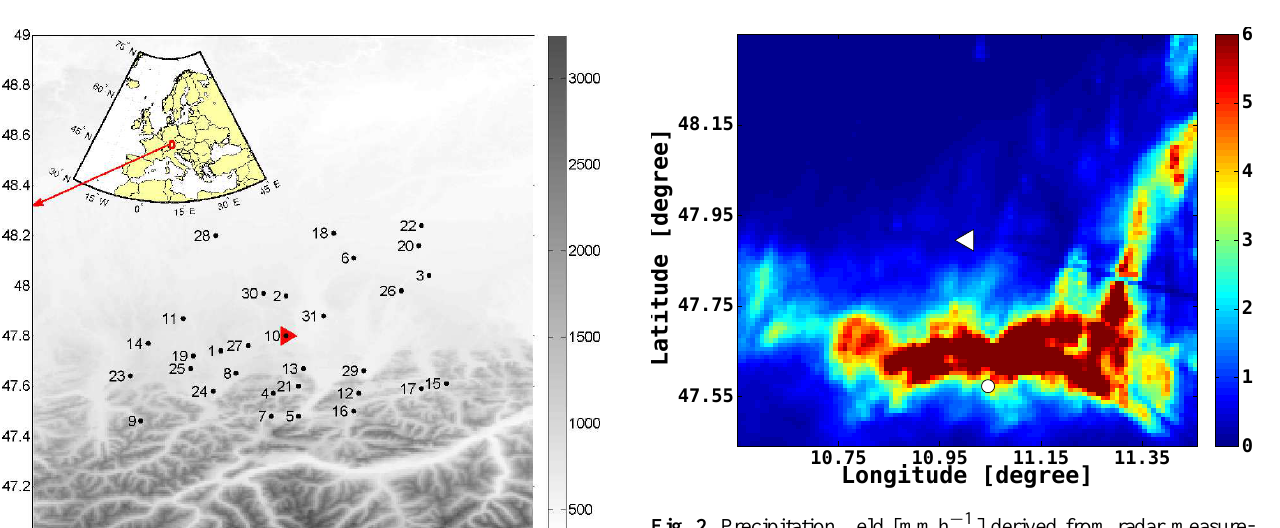
northern part to more than 2000 mm in the south. Figure 1 shows an overview over the study area, highlighting the large north-southerly gradient in altitude.